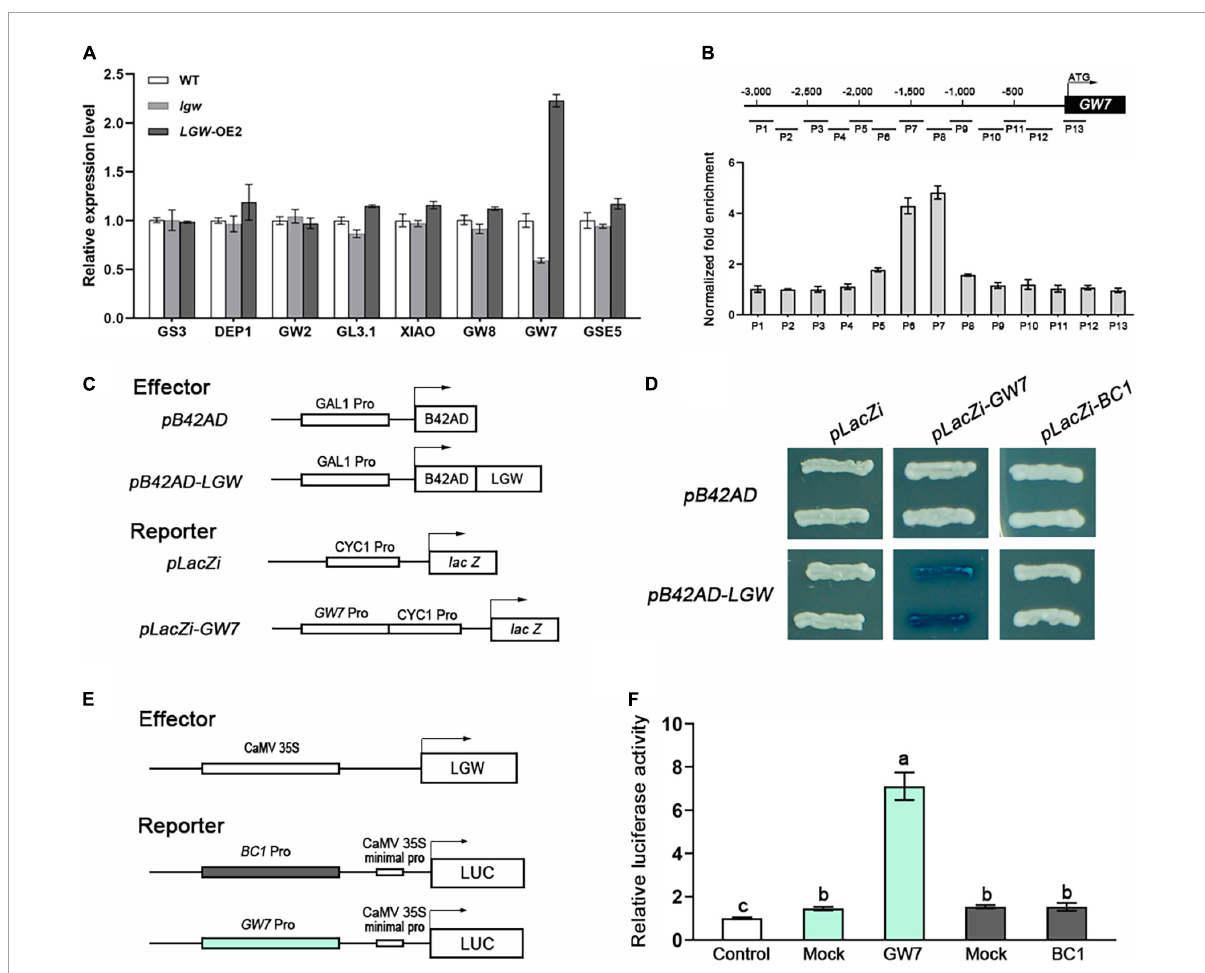
FIGURE6 LGW directly regulates GW7 expression. (A) Expression analysis of grain size regulators in WT, lgw, and LGW-OE2 plants. (B) ChIP assay. LGW-Flag mediated ChIP-qPCR enrichment (relative to Input) of CCA(N)nTGG-containing promoter fragments from GW7 . Error bars, SE of three biological replicates. (C) Diagrams of the reporter and effector constructs used in (D) . (D) Yeast one-hybrid assays. LGW activates LacZ reporters driven by GW7 . The empty pLacZi and pB42AD were used as a negative control. (E) Diagrams of the reporter and effector constructs used in (F) . (F) LGW activates transcription of the GW7 . Mock, co-expressed with the reporter and an empty effector construct; control, co-expressed with an effector and an empty reporter construct (set to 1). Error bars, SE of three biological replicates. Different letters denote significant differences ( P < 0.05) from Duncan’s multiple range